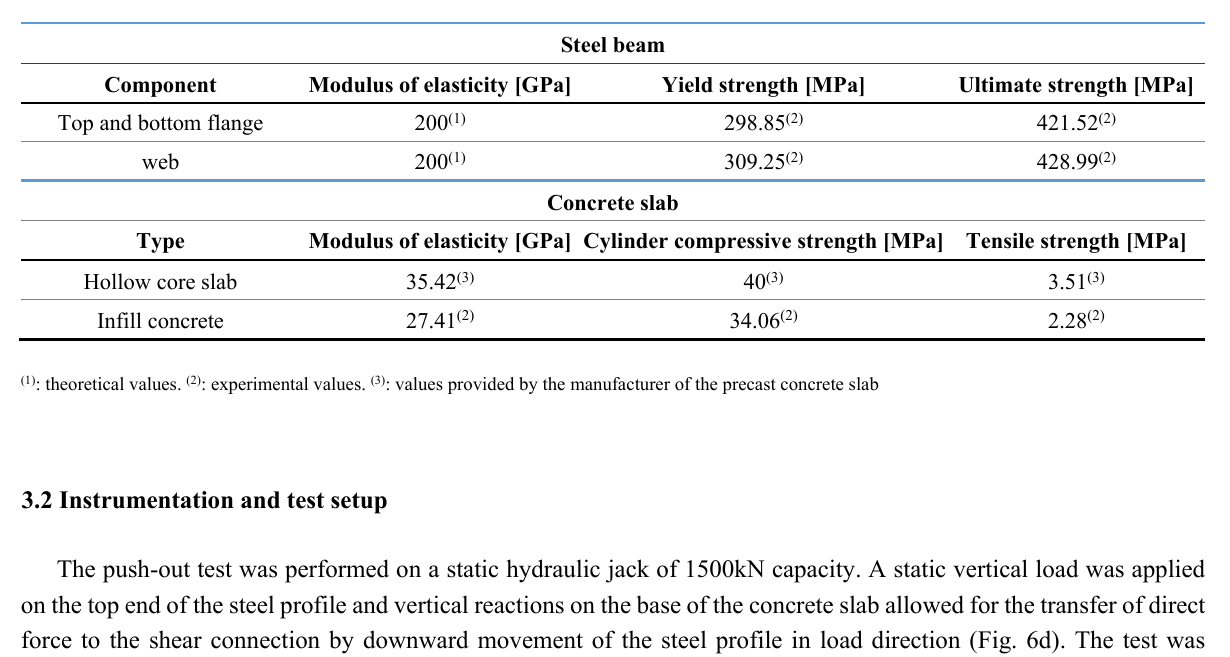
Table 2: Material properties